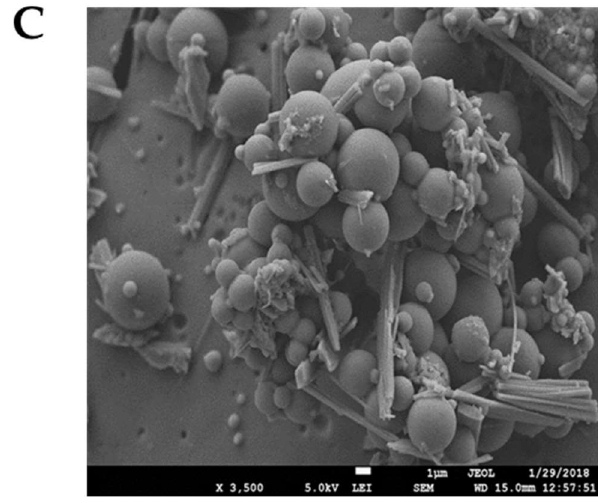
Figure 1. ( A ) The structure of quercetin, PLGA and Schematic representation of the technique for preparation of the quercetin-PLGA nanoparticle formulation. ( B ) DLS size distribution of the Q-PLGA. ( C ) Scanning electron microscopy (SEM) microphotographs of Q-PLGA. Scale bars:100 nm .